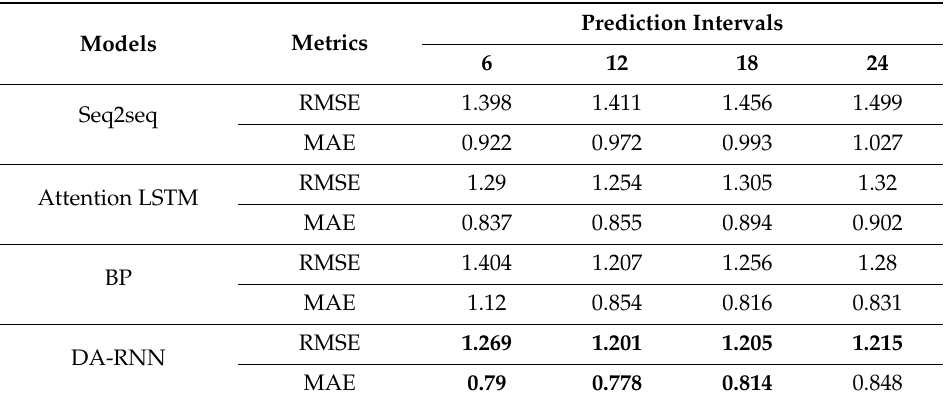
Table 4. Prediction results of di ff erent time intervals.